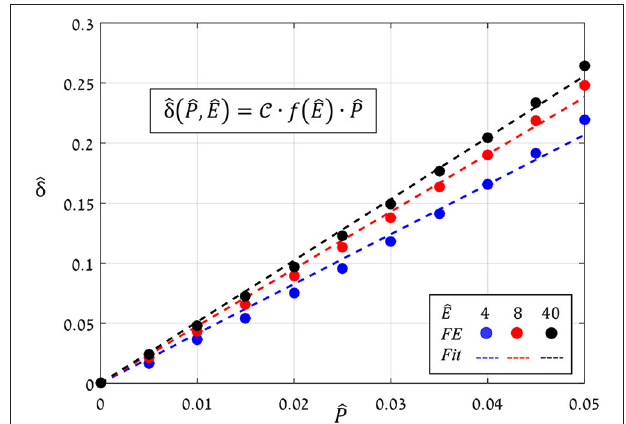
4, 8, and 40 (blue, red and black =